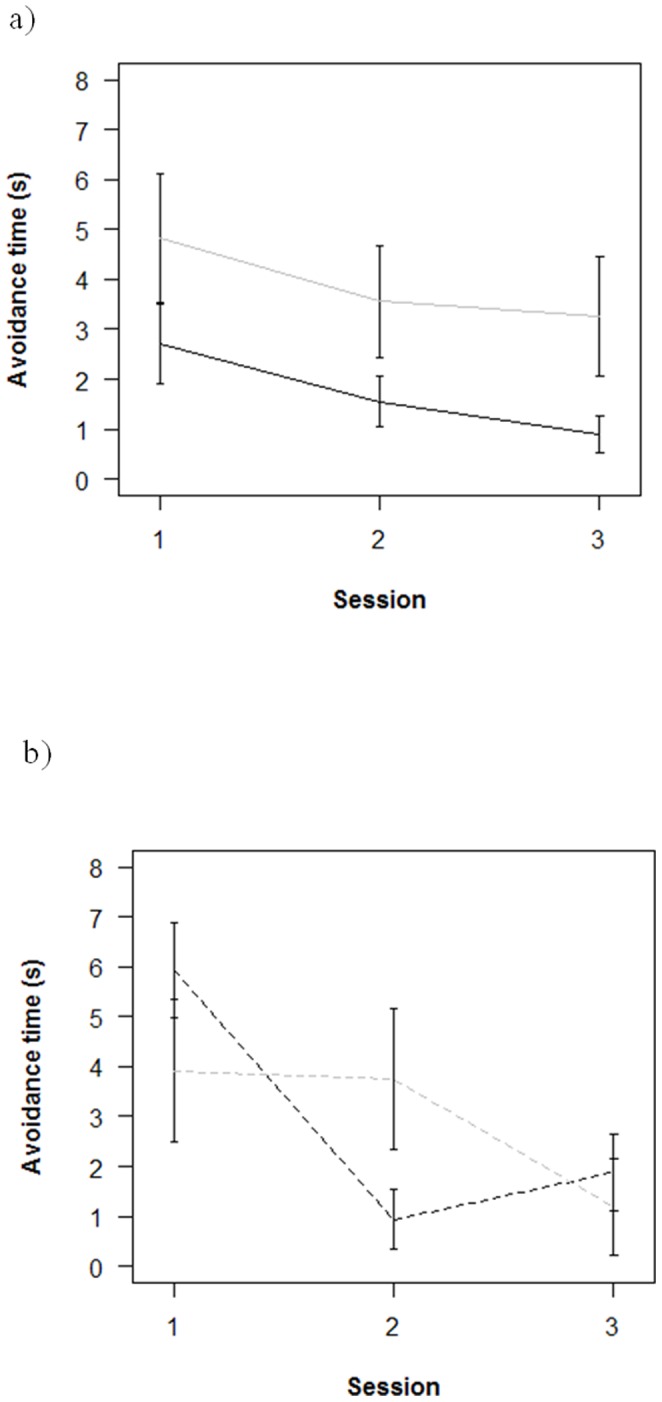
Groups with experienced Key individuals (black lines) were better able to avoid the stimulus.Groups with experienced Key individuals were better at avoiding the stimulus than were groups in which the experienced fish was a non-Key fish (gray lines). 3a) In PN fish, the effect of social role was in terms of faster escape for groups with experienced Key fish (solid black line) than for groups with experienced non-Key fish (solid gray line) at all three sessions. 3b) In SH fish, the difference was in terms of faster improvement: by the second session (S2) for groups with experienced non-Key fish (gray dashed line), but only by the third session (S3) for groups with experienced non-Key fish (gray solid line). Error bars are one standard error. Data are for the same trials as in Fig. 4, but combining data from males and females.